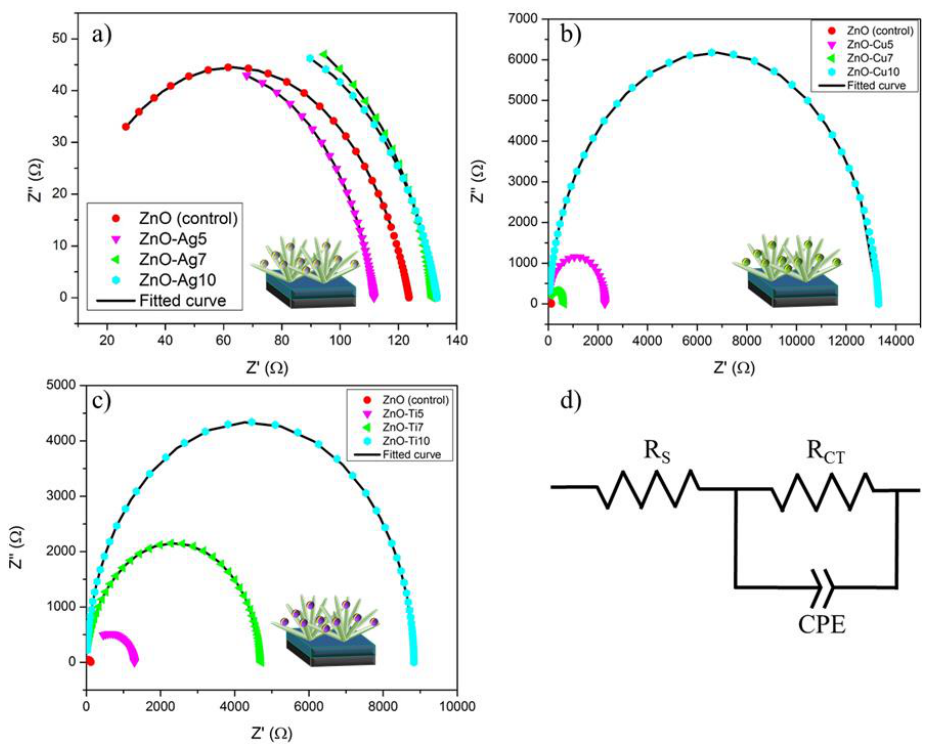
Figure 8. EIS and fitted curves for ( a ) ZnO − Ag (5, 7, and 10), ( b ) ZnO − Cu (5, 7, and 10), ( c ) ZnO − Ti (5, 7, and 10), and ( d ) EIS schematic circuit. Table 2. EIS raw and fitted curve parameters for ZnO (Ag, Cu, and Ti).